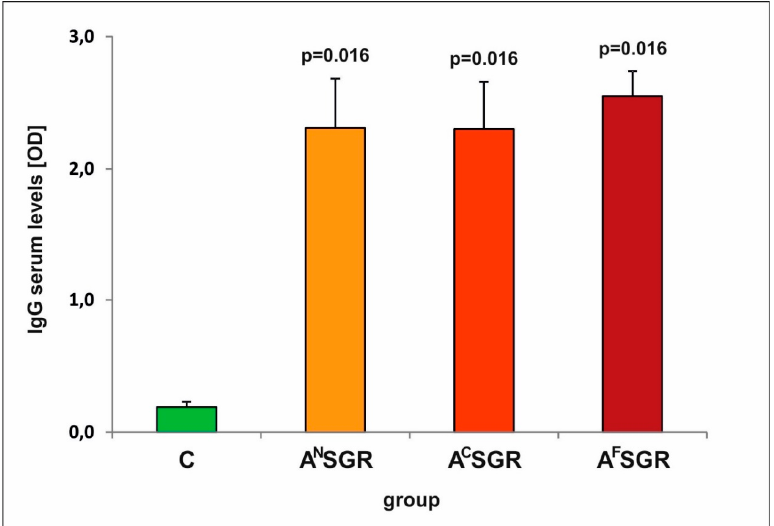
Figure 2. Reactivity of specific IgG antibodies present in sera from control (C: n = 5) and immunized (A N SGR, A C SGR, A F SGR: n = 4) mice with TLA. p values are provided above the bars to indicate significant differences in reactivity between immunized mice and control mice (C).